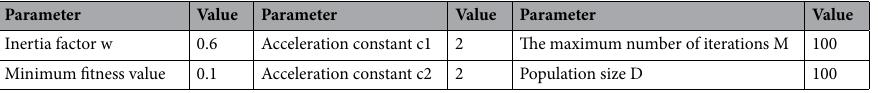
Table 3. Particle swarm algorithm parameter